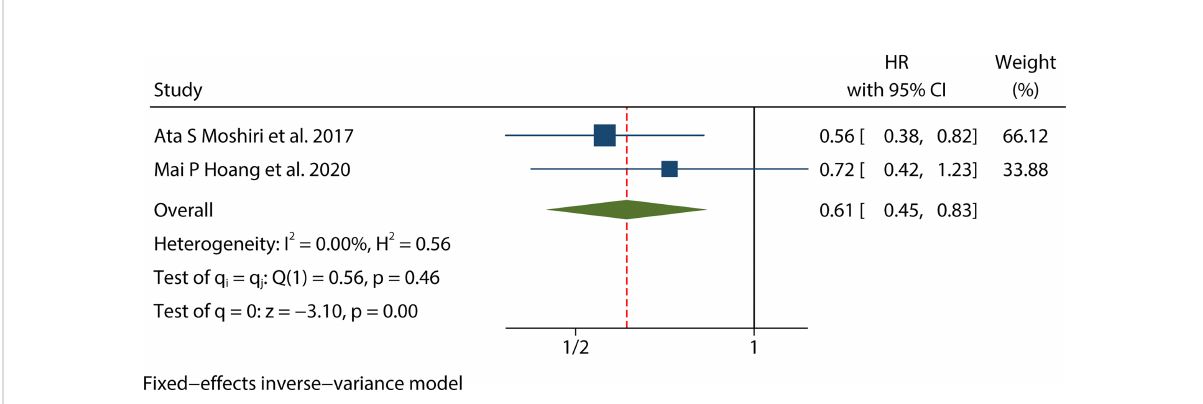
FIGURE 6 Forest plot of the hazard ratio for the association between the MCPyV positivity and Progression-free Survival (PFS) in patients with Merkel cell carcinoma. (univariate